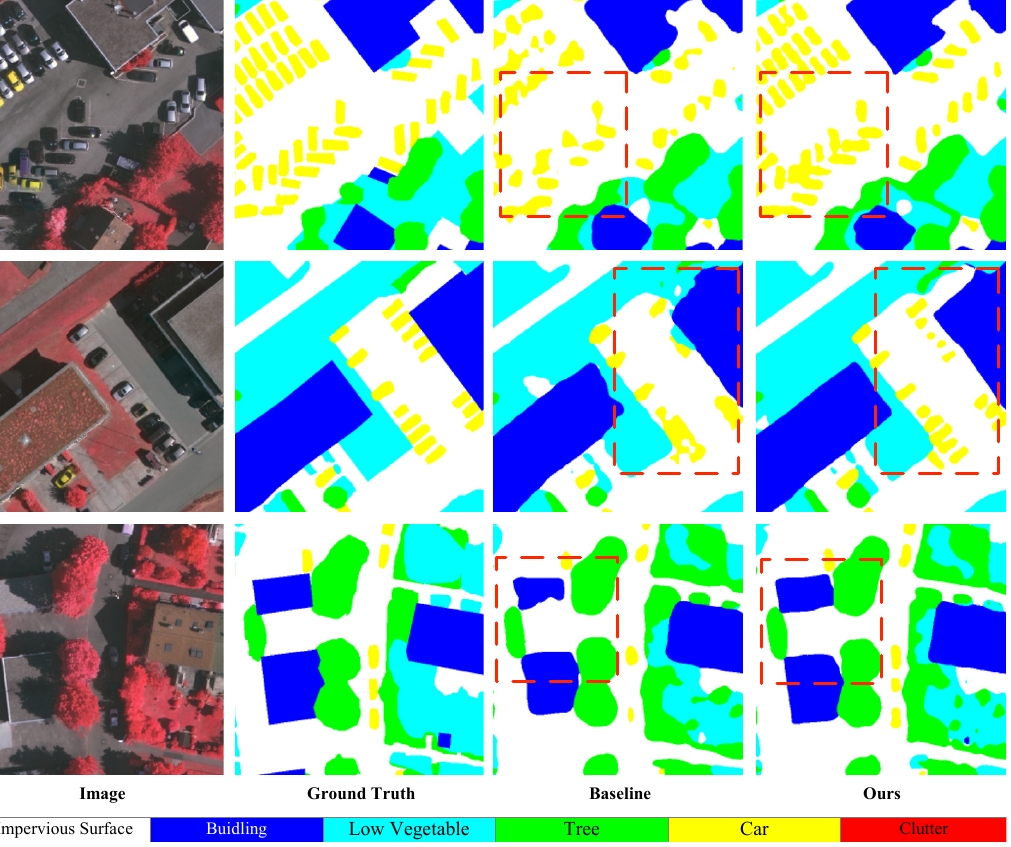
Figure 9. Qualitative comparisons between our method and Baseline on Vaihingen test set. We marked the improved regions with red dashed boxes (best viewed when colored and zoomed